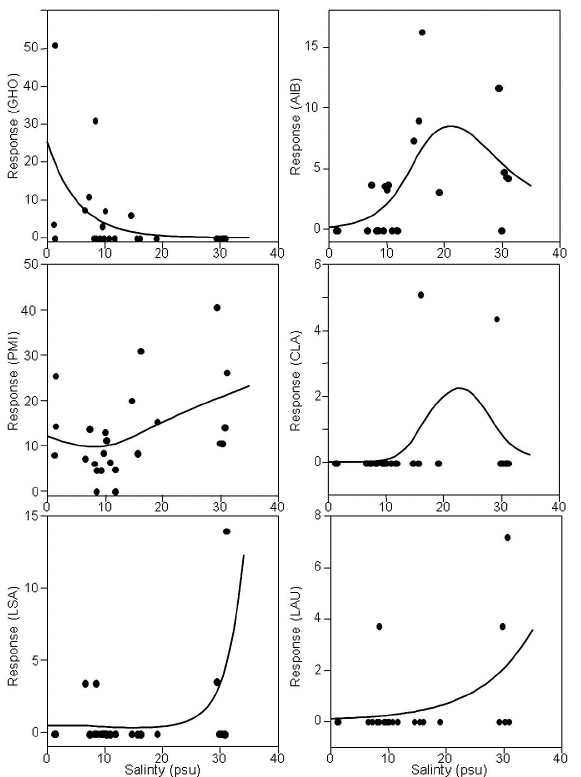
f ig . 4. – Response curves of species abundance (species selected by the model) to salinity. The curves are the generalized additive models (GAM) selected by the Akaike information criterion (AIC). Dots represent sampling sites. See Fig. 3 for species abbreviations.